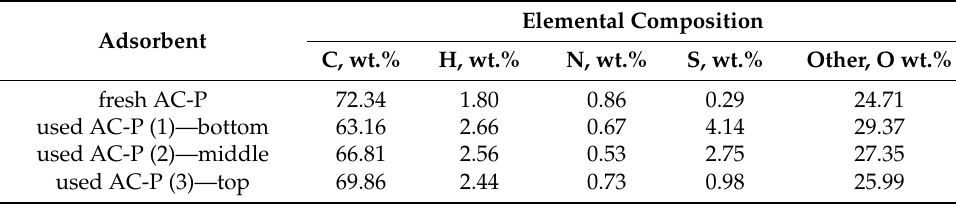
Table 1. The elemental composition of the fresh and used activated carbon